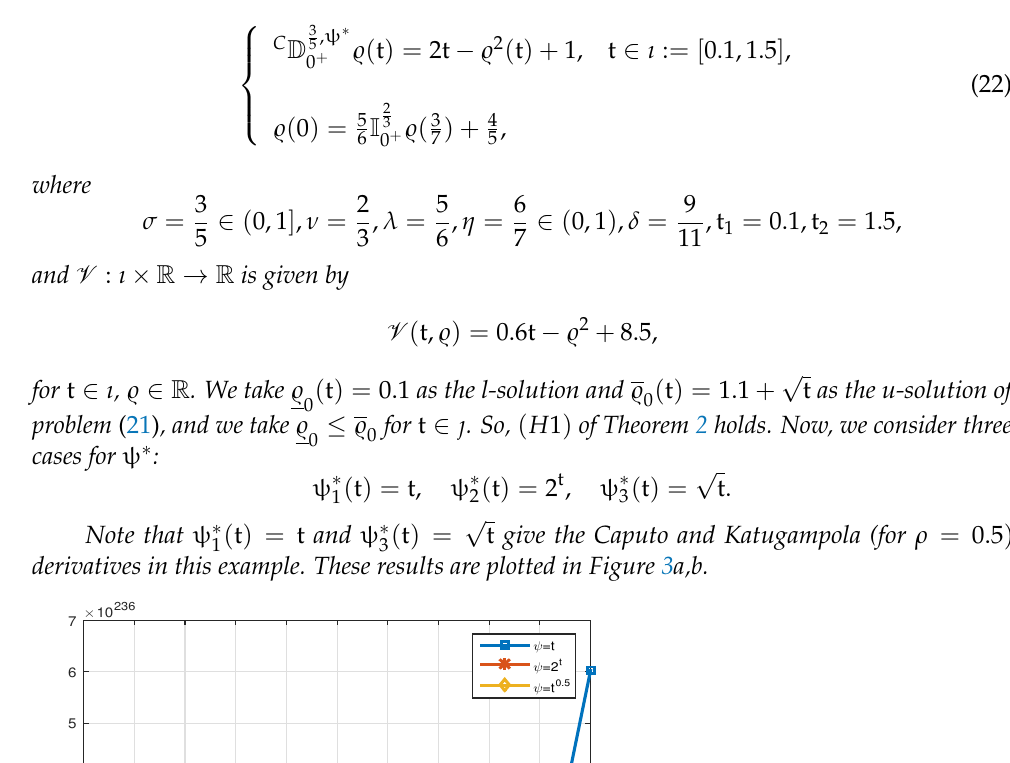
( t ) and (cid:36) ( t ) in ( a ) and ( b ) respectively for the ψ ∗ n √ n ( t ) = t Katugampola derivative (for ρ = 0.5) in 3